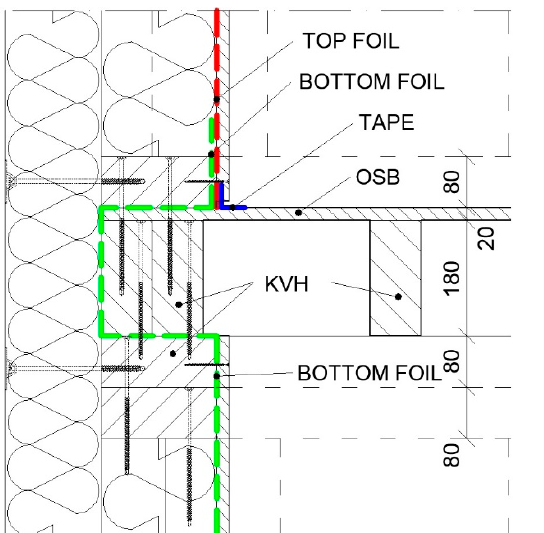
Figure 8. Schematic marking and positioning of sensors.